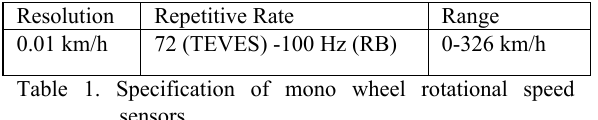
Table 1. Specification of mono wheel rotational speed